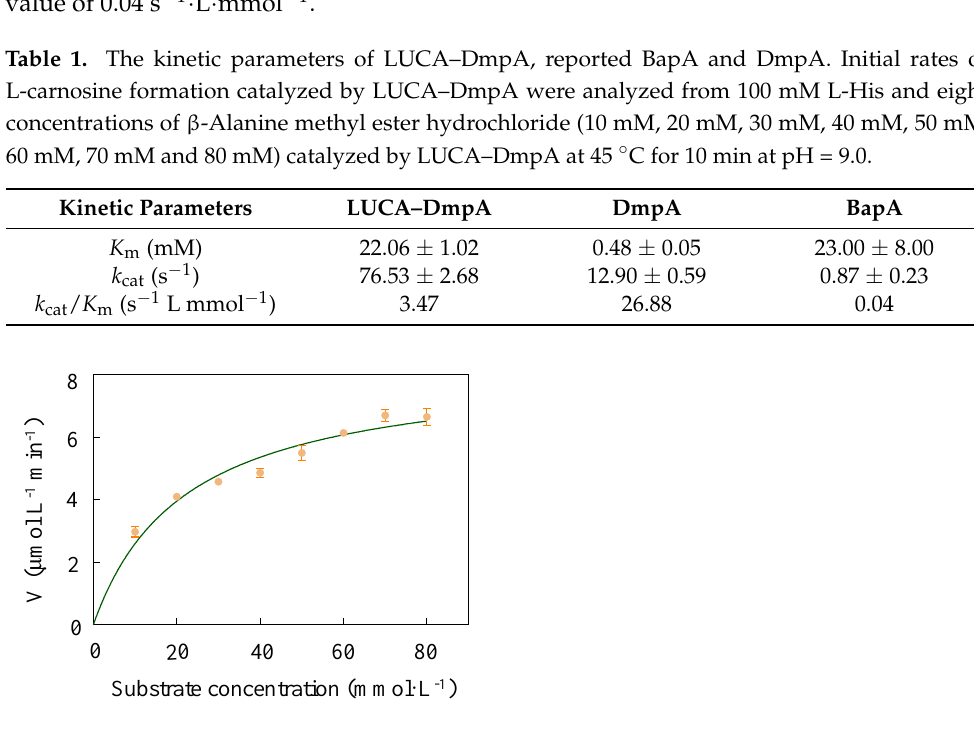
Figure 6. The kinetic parameters of LUCA–DmpA. Initial rates of L-carnosine formation were analyzed in reaction systems containing 100 mM L-His and eight concentrations of β -Alanine methyl ester hydrochloride (10 mM, 20 mM, 30 mM, 40 mM, 50 mM, 60 mM, 70 mM and 80 mM) at optimal temperature (45 °C) and pH (9.0).